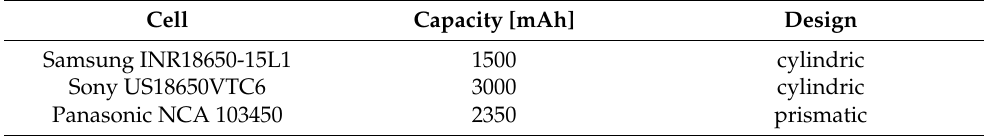
Table 1. Cells investigated for state